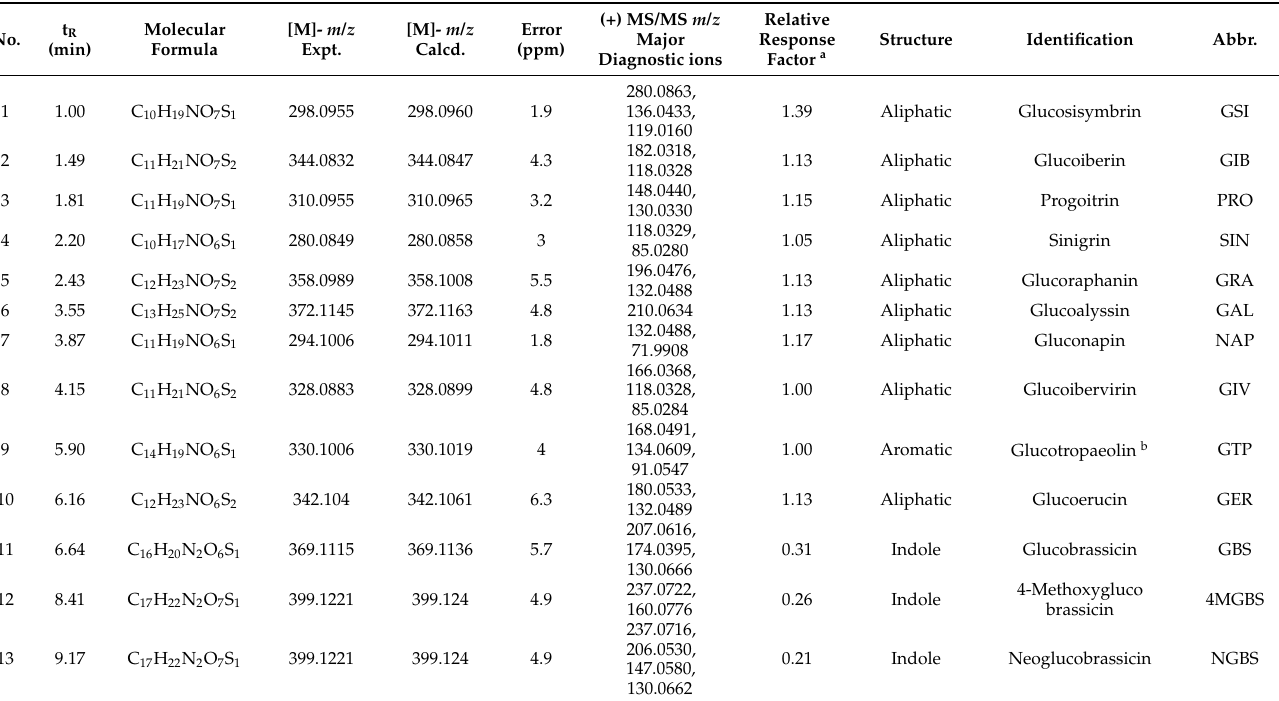
Table 1. Retention times (t R ) and MS/MS fragmentation data for the desulfo-GLs of broccoli ( Brassica oleracea var. italica ) in positive ionization